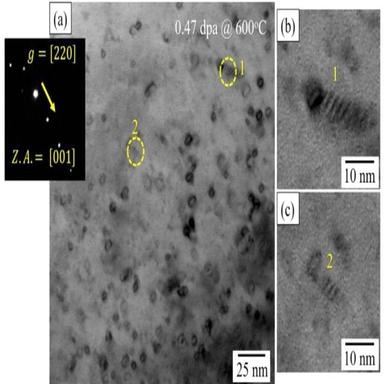
(a) Kinematic bright field TEM image of ThO2 with g = strongly excited near zone after 0.47 dpa proton irradiation at 600oC; (b), (c) enlarged images at location 1 and 2, respectively.